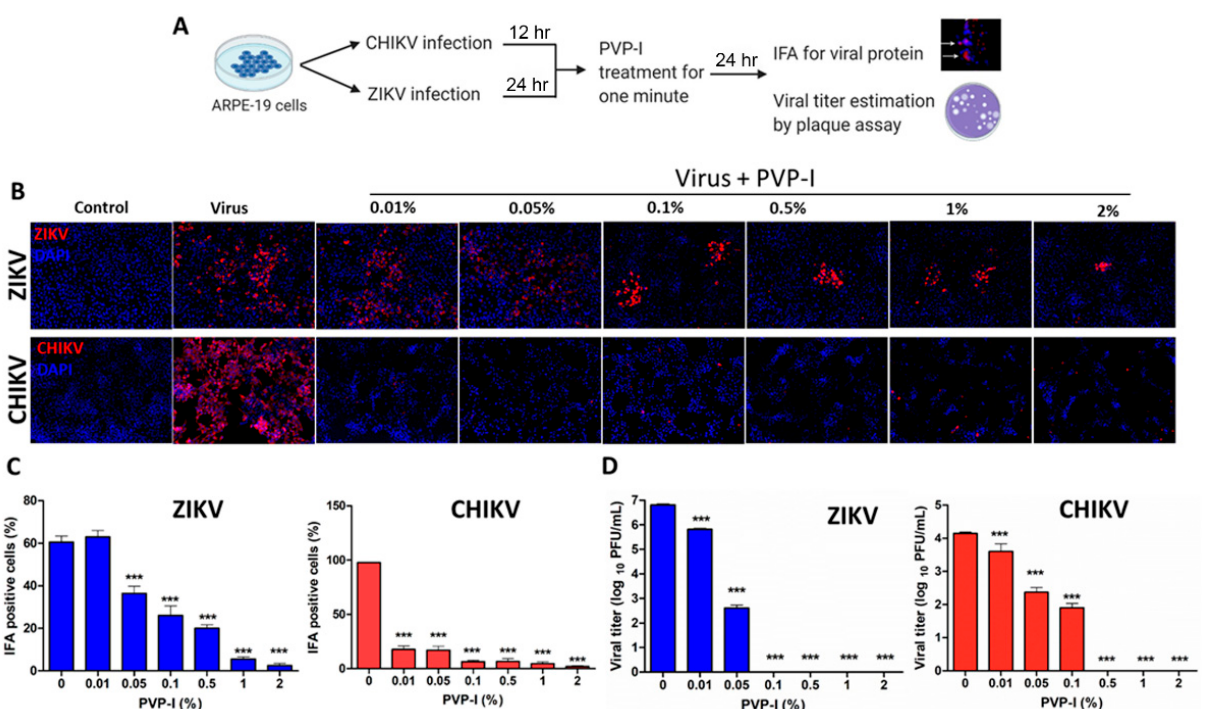
Figure 2. PVP-I exposure attenuates viral replication and production of viral progeny in retinal pigment epithelial cells. Schematic representation of the experimental design ( A ). ARPE-19 cells were infected with ZIKV and CHIKV for 24 h and 12 h, respectively. Infected cells were treated with indicated concentrations of PVP-I for one minute and extensively rinsed to remove residual PVP-I, and cultured for another 24 h in fresh media. Viral replication was assessed by immunofluorescent detection of viral antigens (red) using anti-Flavivirus 4G2 (ZIKV) and anti-CHKV E1 antibodies in fixed cells. The cell nuclei were counterstained using DAPI (blue). The images were captured at 20X magnification using the Keyence BZ-X800 series microscope ( B ). The cells expressing viral protein were counted and presented as IFA-positive cells (%) relative to the total number of cells from four independent fields ( C ). The culture supernatant was used to perform plaque assay on the Vero cell monolayer and the viral titer was expressed as log 10 PFU/mL ( D ). One-way ANOVA with Dunnett’s test was used for statistical analysis, wherein *** p < 0.001.